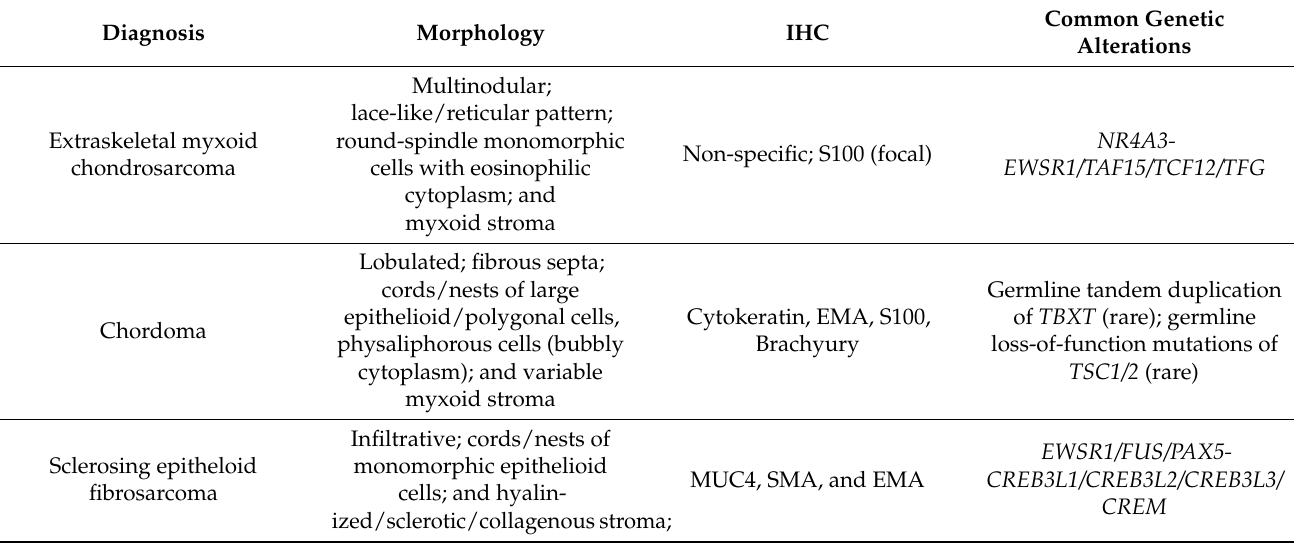
Table 9. Differential diagnoses of myoepithelial